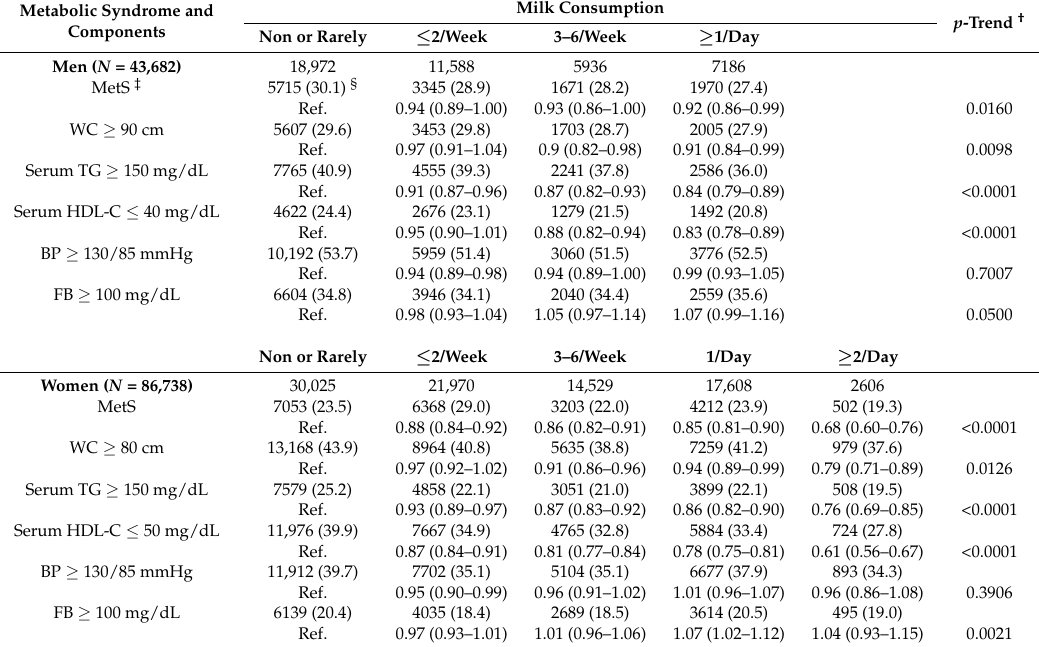
Table 2. Odd ratios (OR) * and 95% confidence intervals (CI) of metabolic syndrome and components according to milk consumption; Ref.